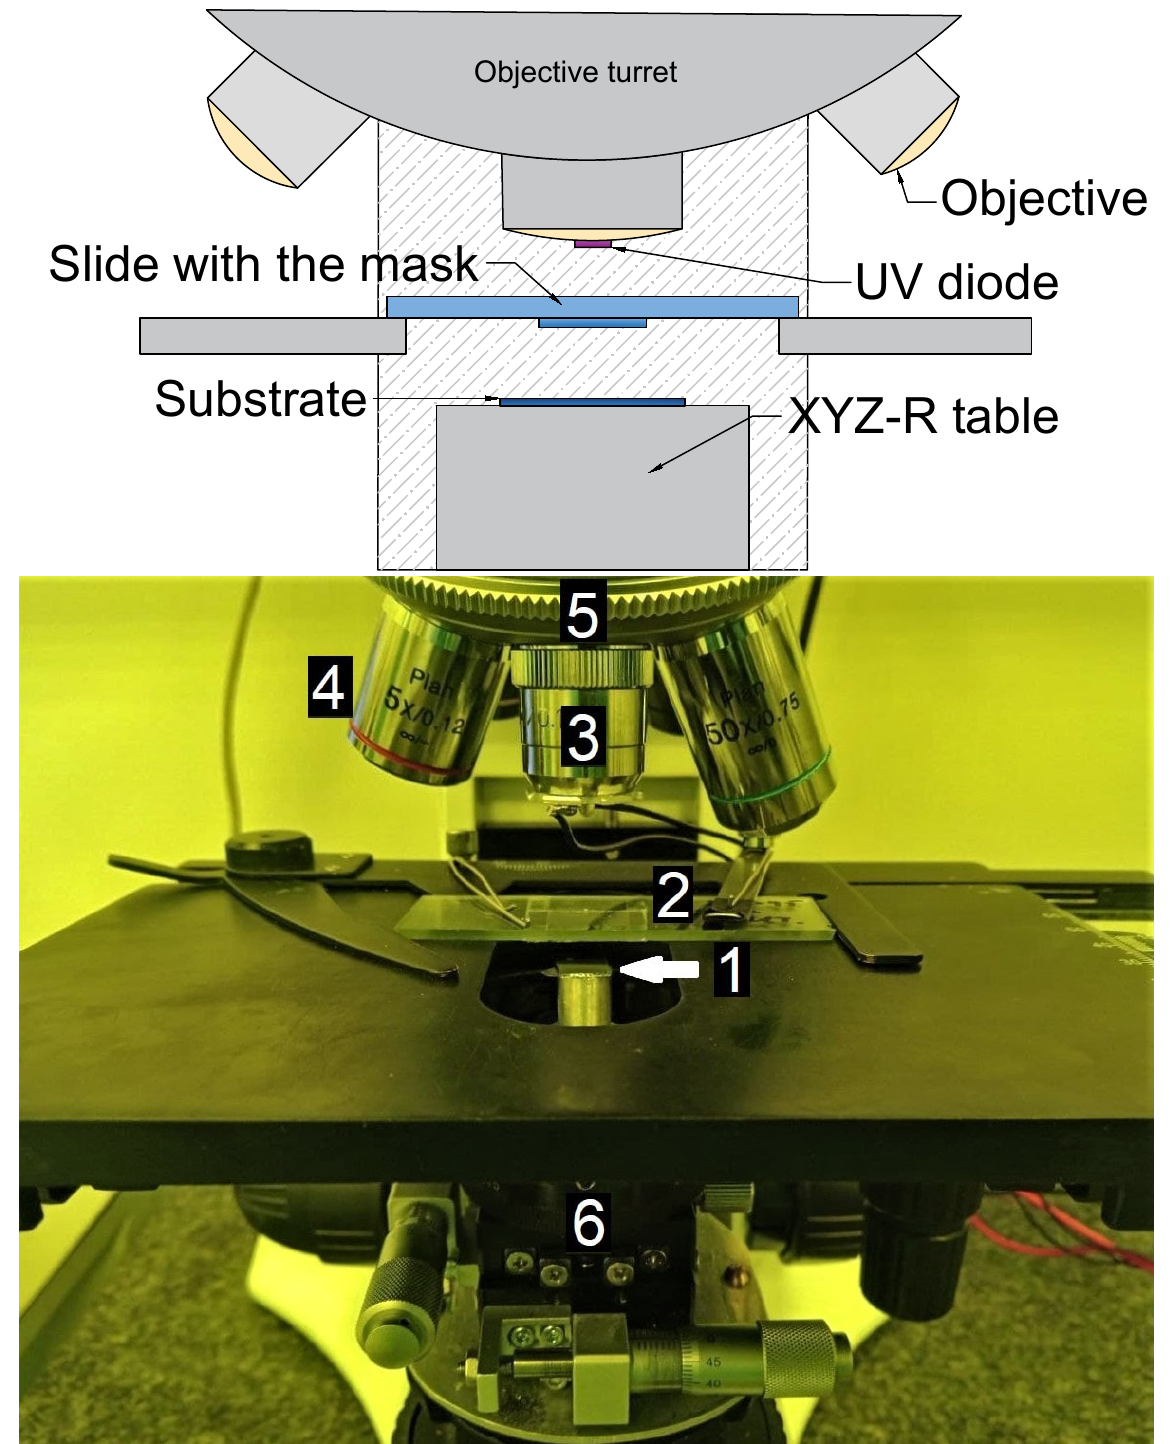
Figure 1. A scheme ( top ) and a photo ( bottom ) of the alignment and exposure microscope kit: 1—the sample fixed to the XYZR stage, 2—mask, 3—UV diode in the lens slot, 4—5 × lens, 5—microscope turret, 6—XYZR